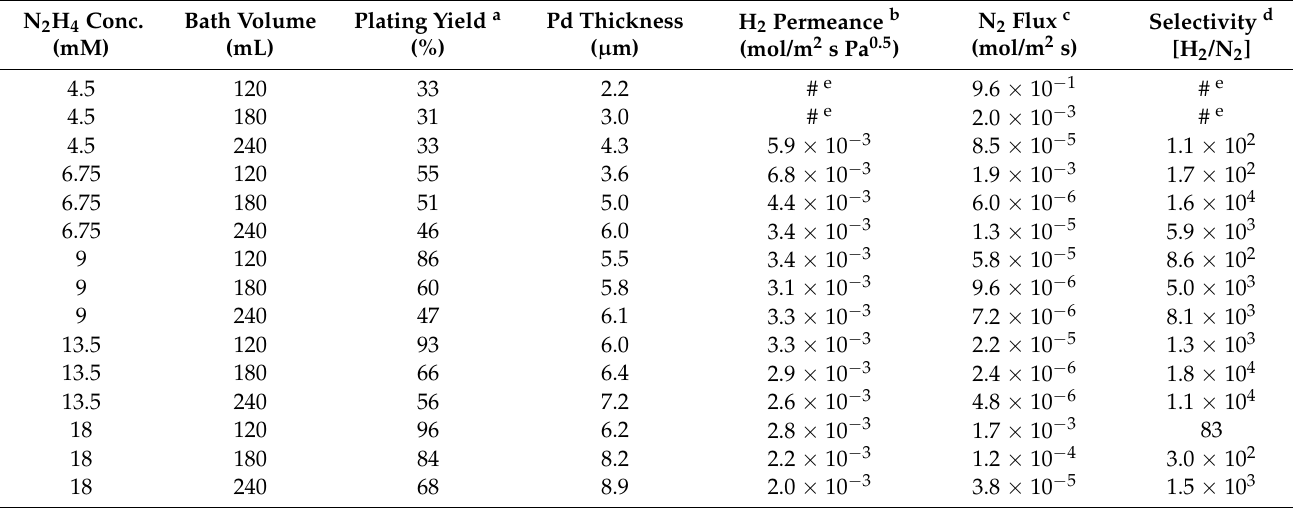
a Ratio of estimated Pd 2+ usage (derived from the weight gain after deposition) and the original Pd 2+ in the bath. b Measured at 400 ◦ C. c Measured at room temperature and 1-bar pressure difference prior to H